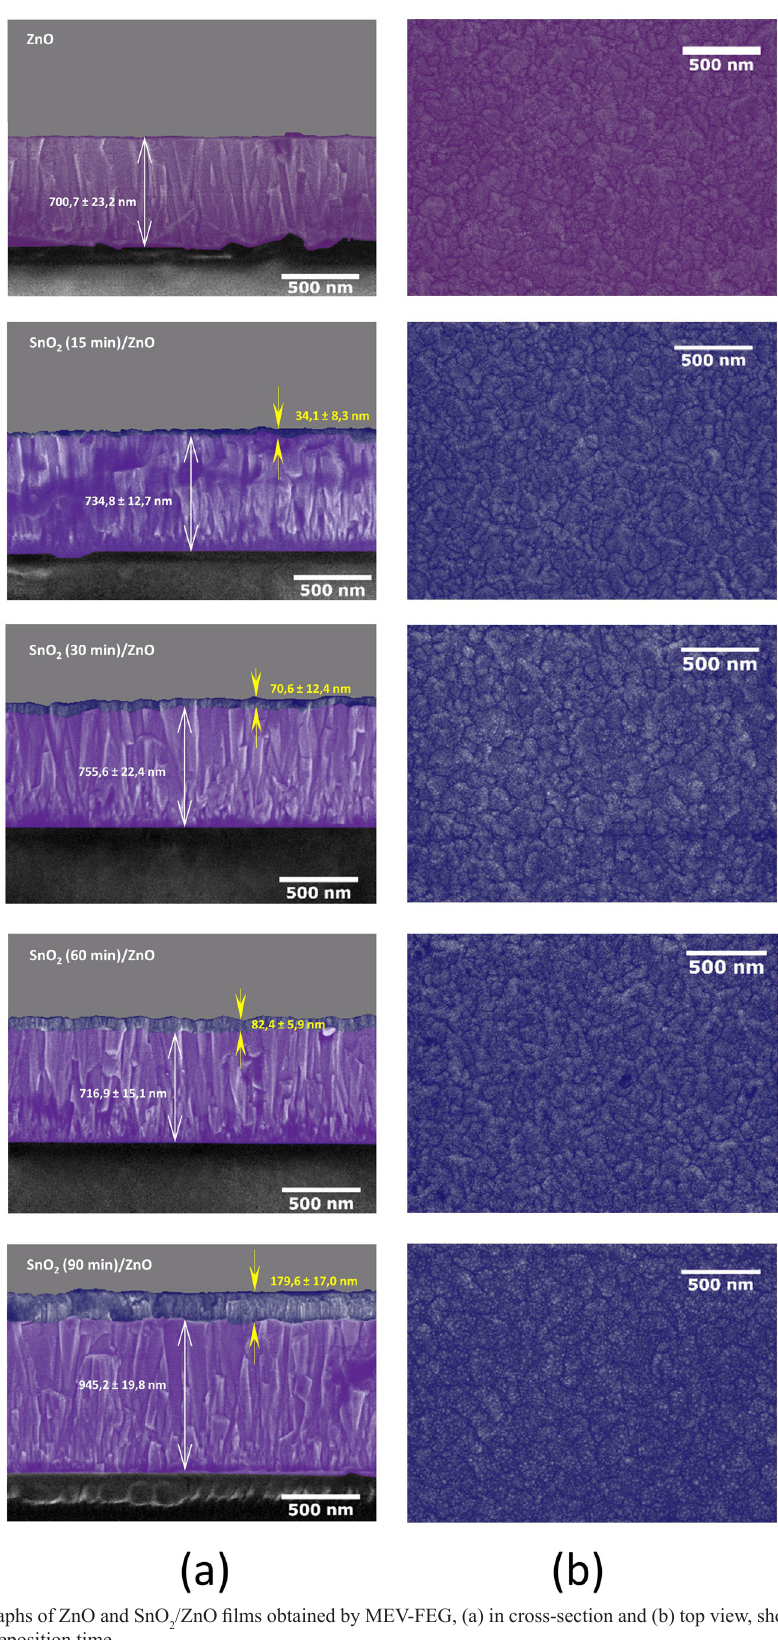
/ZnO films obtained by MEV-FEG, (a) in cross-section and (b) top view, showing the evolution Figure 2. Micrographs of ZnO and SnO 2 of the SnO with deposition 2